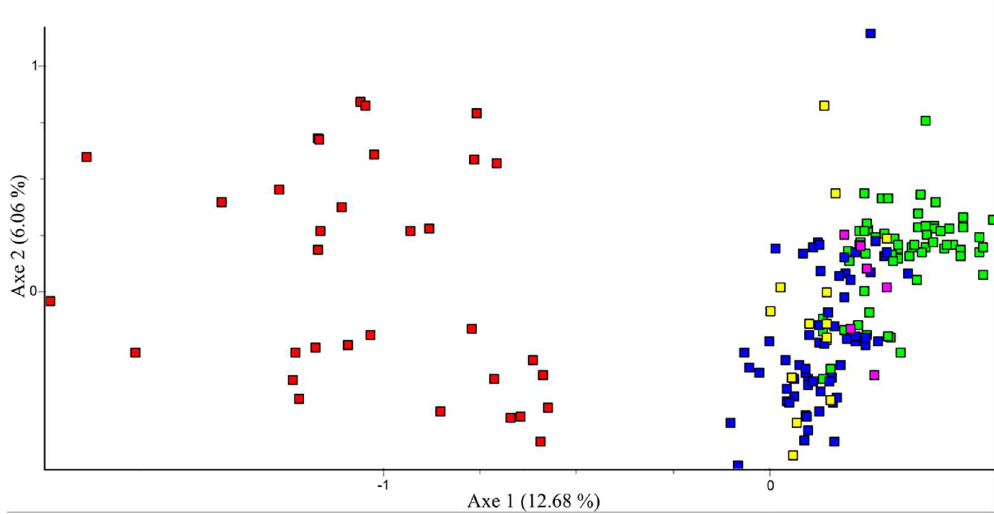
Fig 4. Factorial Correspondence Analysis using 14 microsatellite loci. General overview of the genetic relationships among Razor-billed Curassows (red); individualsassigned to Alagoas Curassow based on morphology, microsatellites, and mtDNA (green); individuals assigned to Alagoas Curassow based on morphology and microsatellites, but excluded by mtDNA analysis (purple); individuals pointed out as admixted by microsatellites, using S TRUCTURE 98% threshold (yellow), and individuals assigned as hybrids based on morphology